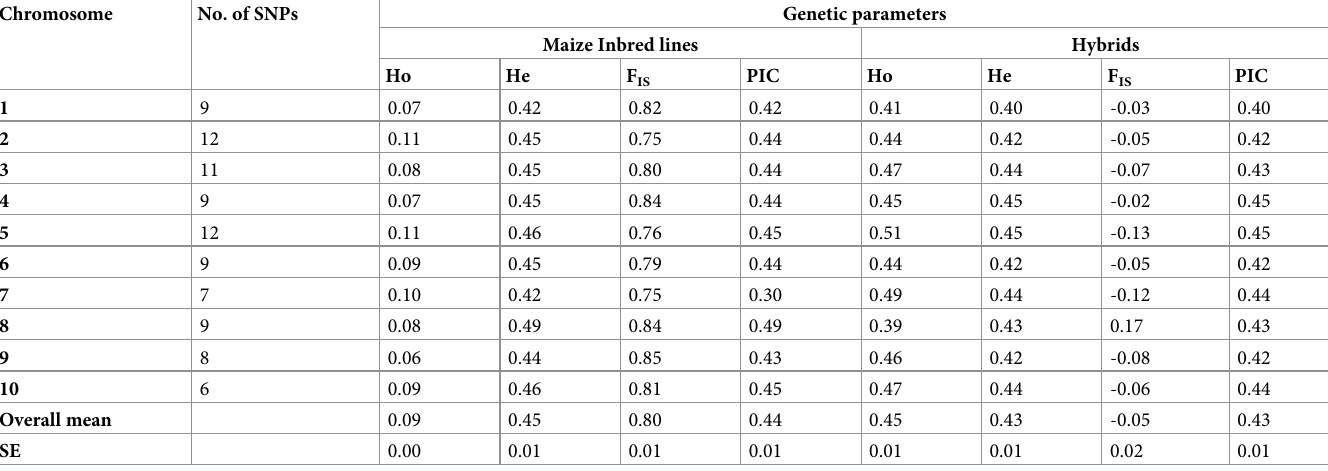
Table 1. Summary of genetic diversity parameters of 92 SNPs per chromosome measured in a set of 188 maize genotypes. Chromosome No. of